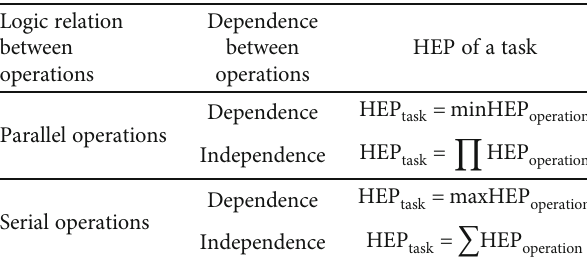
Table 5: Calculation principles for the HEP of a